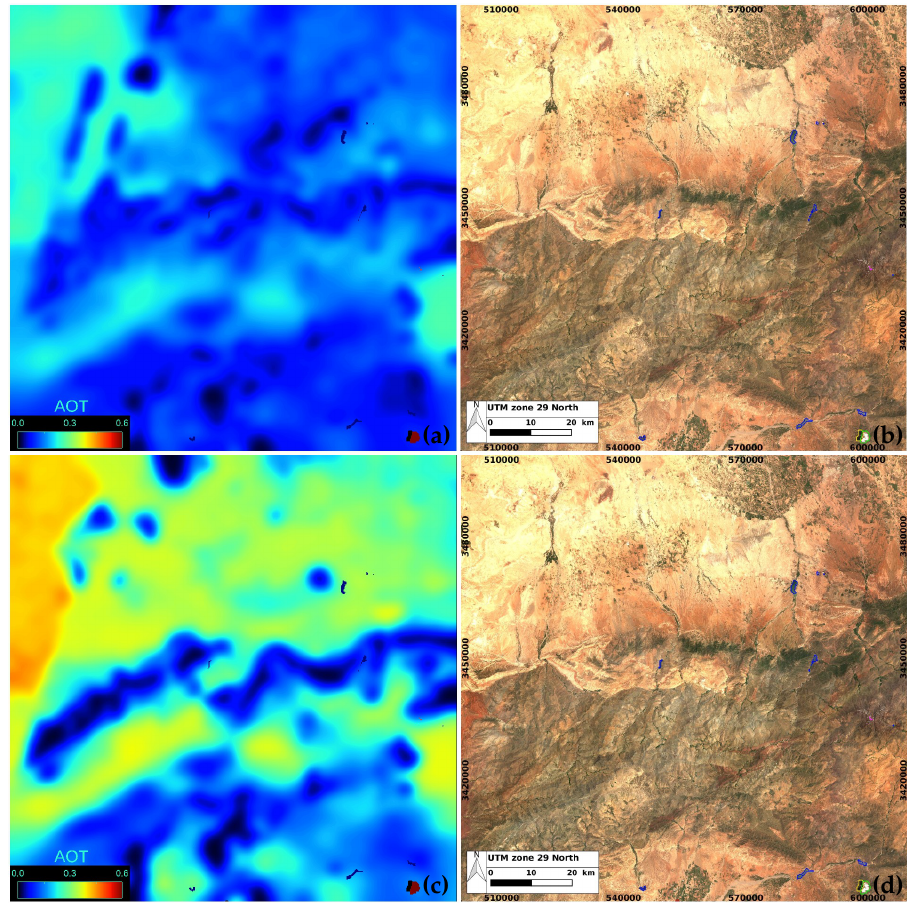
Figure 5. Ouarzazate (Morocco) on 6 June 2016: ( a ) estimated aerosol optical thickness (AOT) at 550 nm; ( b ) surface reflectance after atmospheric correction using the constant aerosol type; ( c ) estimated AOT at 550 nm; and ( d ) surface reflectance after atmospheric correction using five CAMS (Copernicus Atmosphere Monitoring Service) aerosol types. For the AOT in ( a , c ), clouds are in dark red, their shadows are in black, water is in blue, and snow in bright red. For the surface reflectance in ( b , d ) clouds are circled in green, their shadows in yellow, water is circled in blue, and snow is in